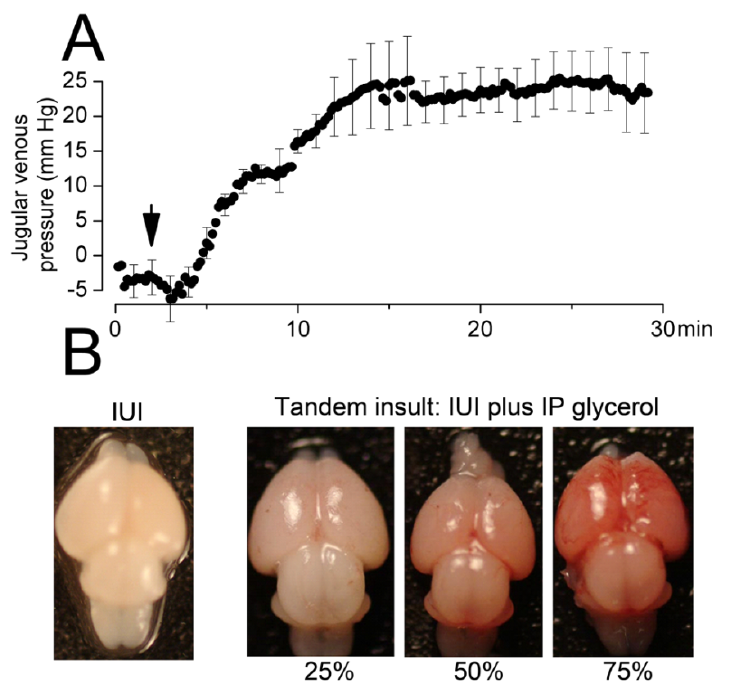
Figure 2. Intraperitoneal glycerol elevates jugular venous pressure and causes brain hemorrhages after intrauterine ischemia (IUI). ( A ) jugular venous pressure as a function of time after injection of 50% glycerol (13 μ L/g IP) (arrow); the values shown are the means ± S.E. for measurements in 3 rat pups that were 2 weeks of age (to facilitate catheterization of the jugular vein). ( B ) images of the dorsal surface of brains from rat pups on P1 that had been subjected to IUI 3 days previously (on E19), without IP injection of glycerol (IUI only), or 24 h after injection of 25%, 50% or 75% glycerol (13 μ L/g IP); all animals underwent transcardial perfusion with normal saline prior to harvesting the brain; the images shown are representative of triplicate experiments.